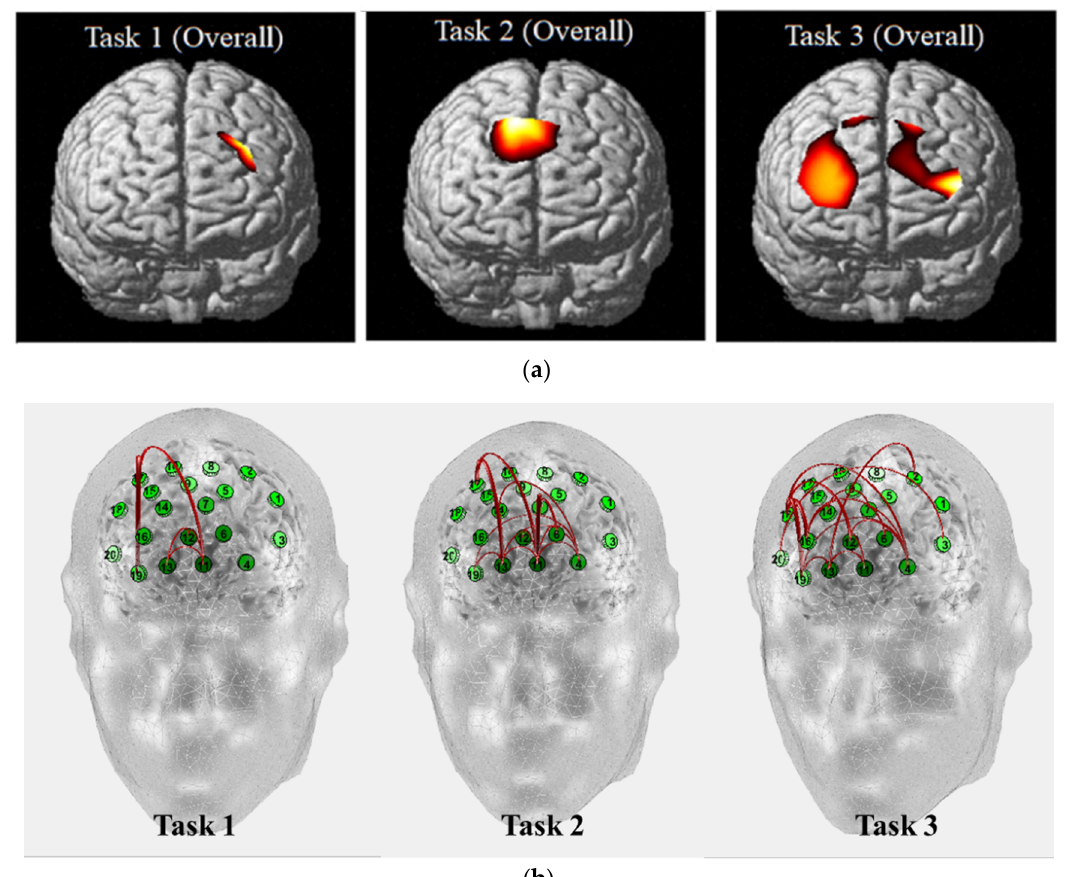
Figure 4. The brain mapping results: ( a ) the activation map, and ( b ) the connectivity map of the prefrontal cortex in each task.